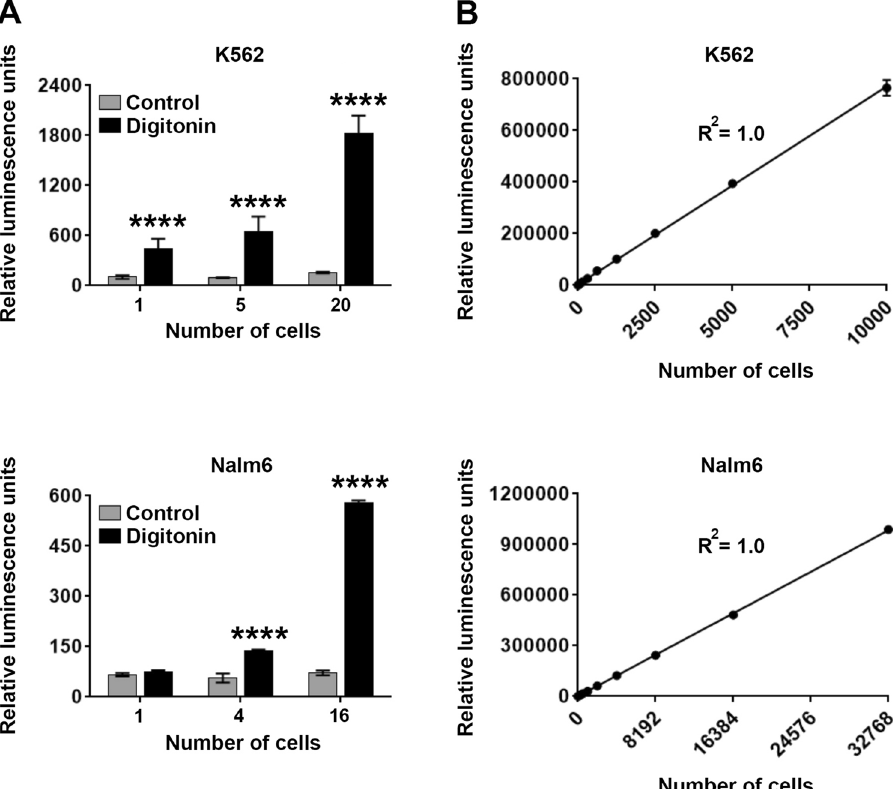
Figure 2. Matador-Glo assay is highly sensitive. ( A ) Indicated cell lines stably expressing Luc146-1H2 were plated in a 384-well at indicated numbers (by serial dilution) and treated with digitonin (30 µg/ml) for 90 min or PBS (control). Luminescence was detected by the addition of D-luciferin containing assay buffer directly to each well. ( B ) Linear increase in luminescence over a wide range of cell numbers in the Matador-Glo assay. Both the number of cells plated and luminescence values detected were plotted. R 2 = Correlation coefficient. The values shown are mean ± SE of a representative experiment performed in triplicate. Statistically significant differences are shown by asterisks (****) at a level of P < 0.0001.